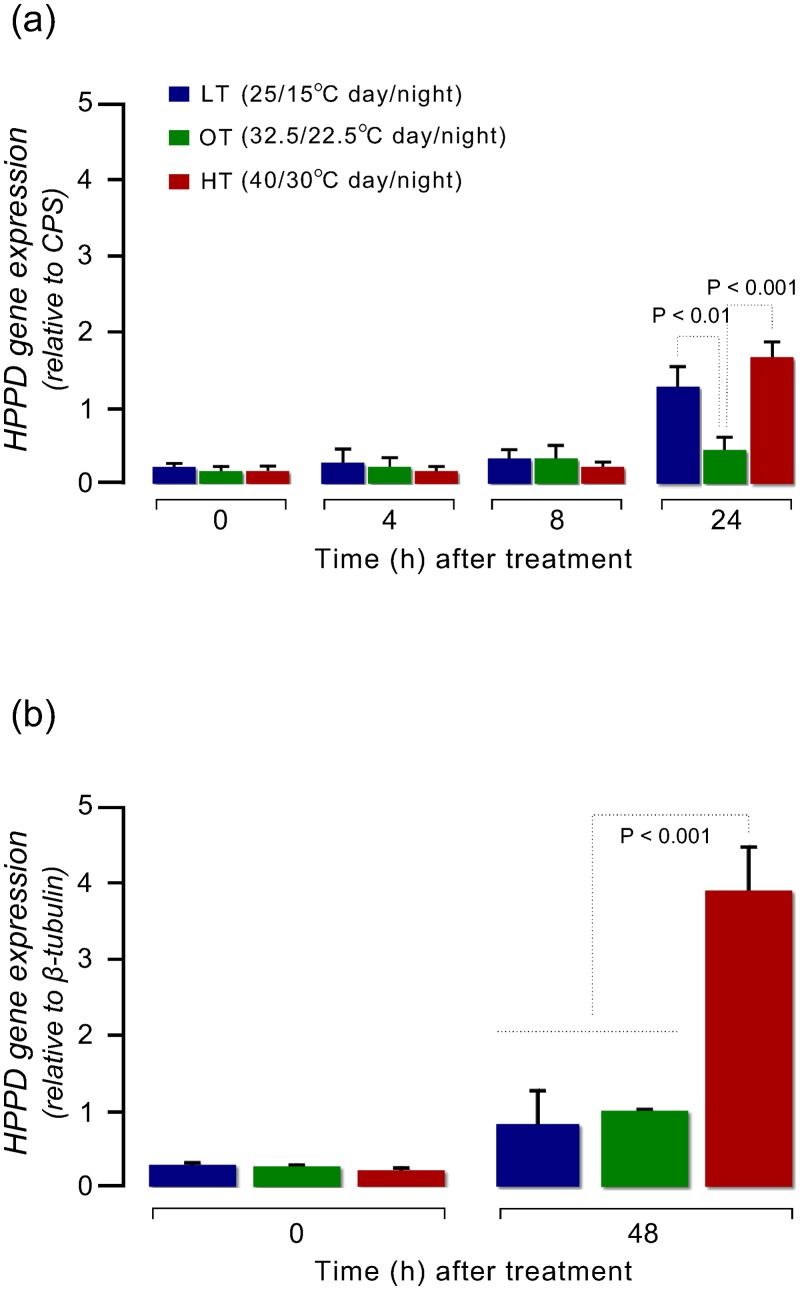
Time course of HPPD expression levels (a) relative to CPS and (b) β-tubulin in mesotrione-treated (105 g ai ha-1, 0.85% w/v AMS, and 1% v/v COC) Palmer amaranth leaves under three different temperatures (low temperature, LT, 25/15°C; optimum temperature, OT, 32.5/22.5°C; and high temperature, HT, 40/30°C; 15/9 h day/night).Total RNA was extracted from a bulked sample of Palmer amaranth leaves. Data represent means of two to three biological samples. Error bars represent SE.